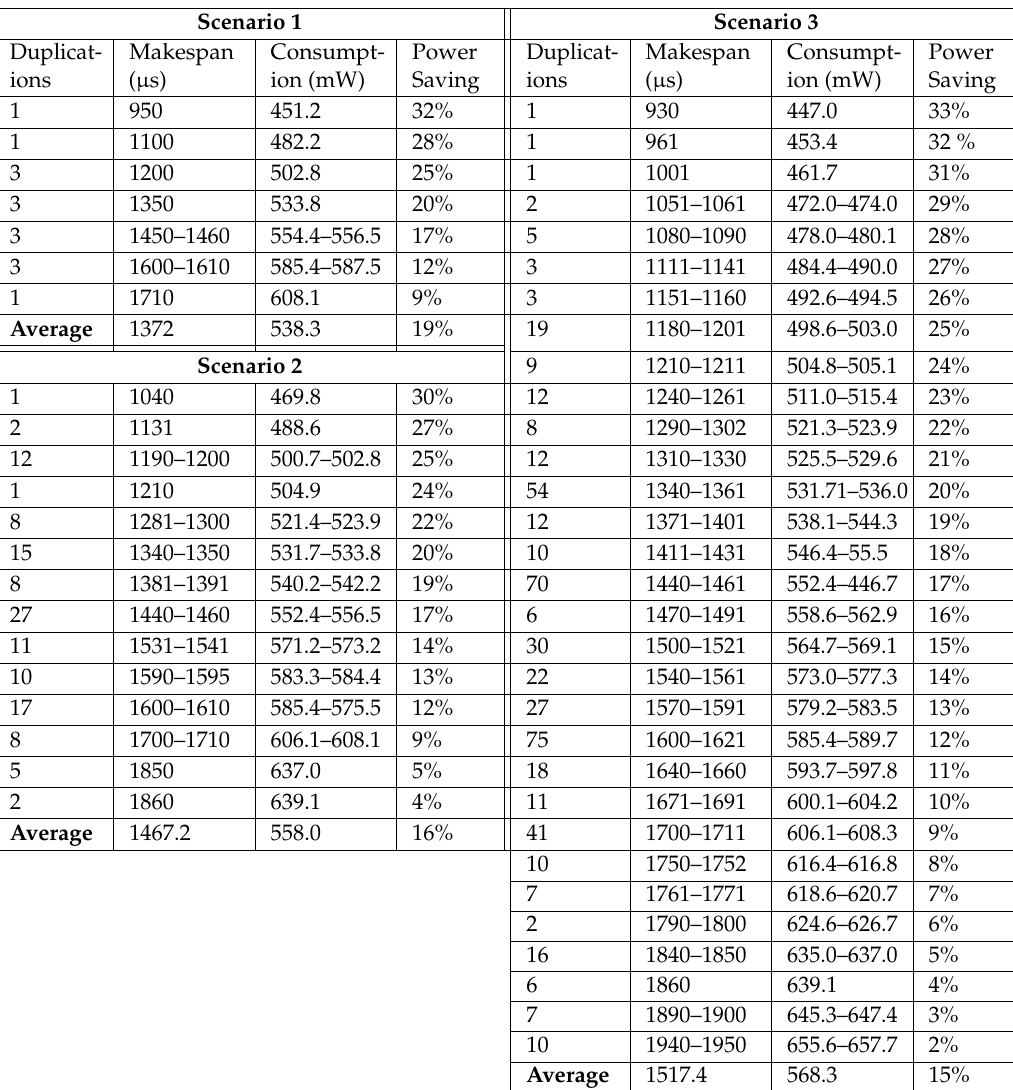
Table 4. Evaluation Results for the three scenarios.